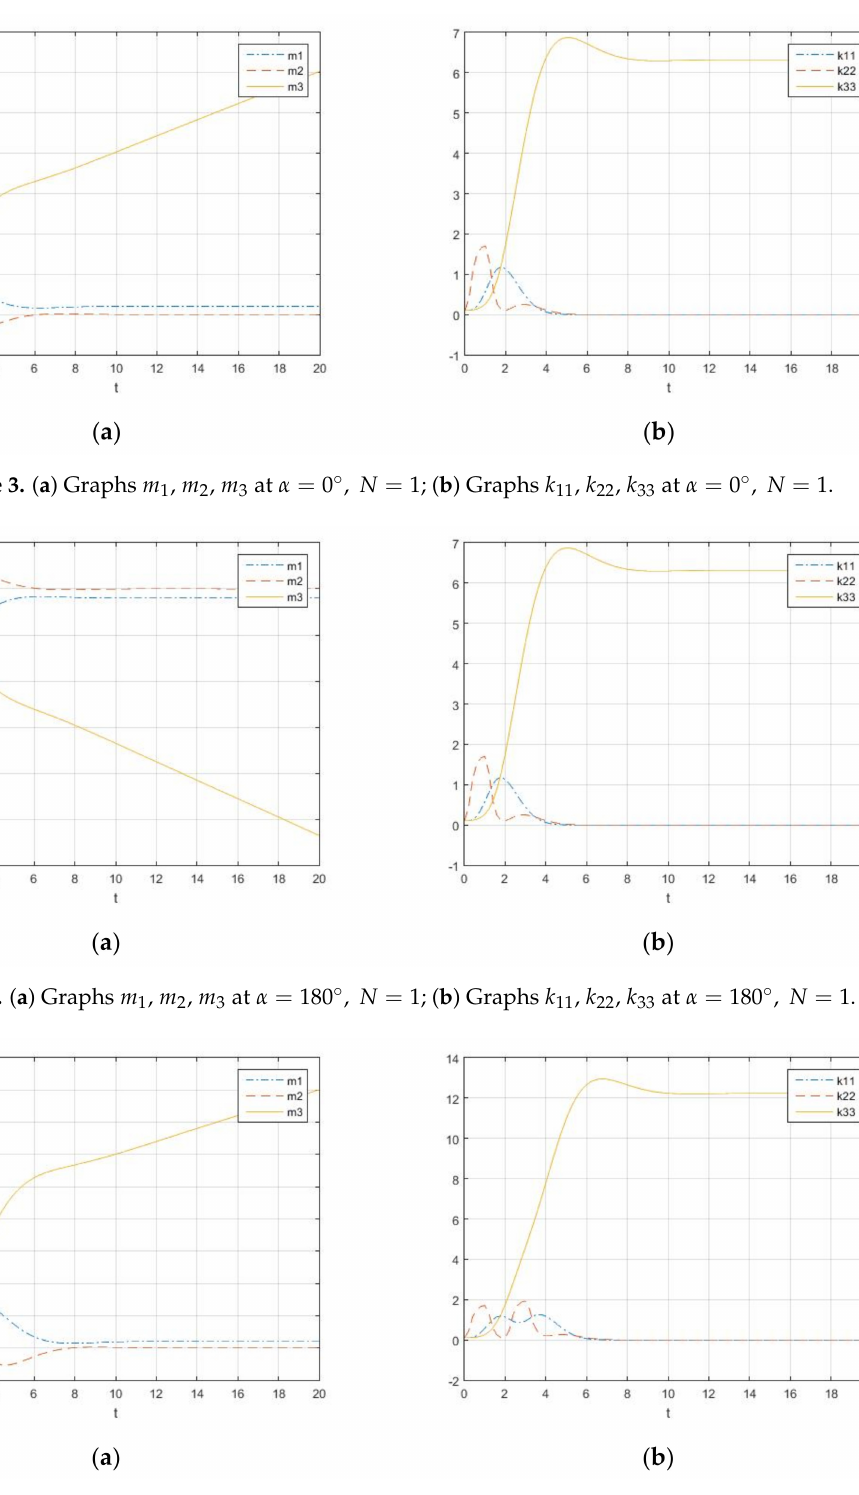
Figure 5. ( a ) Graphs m 1 , m 2 , m 3 at α = 0 ◦ , N = 2; ( b ) Graphs k 11 , k 22 , k 33 at α = 0 ◦ , N =